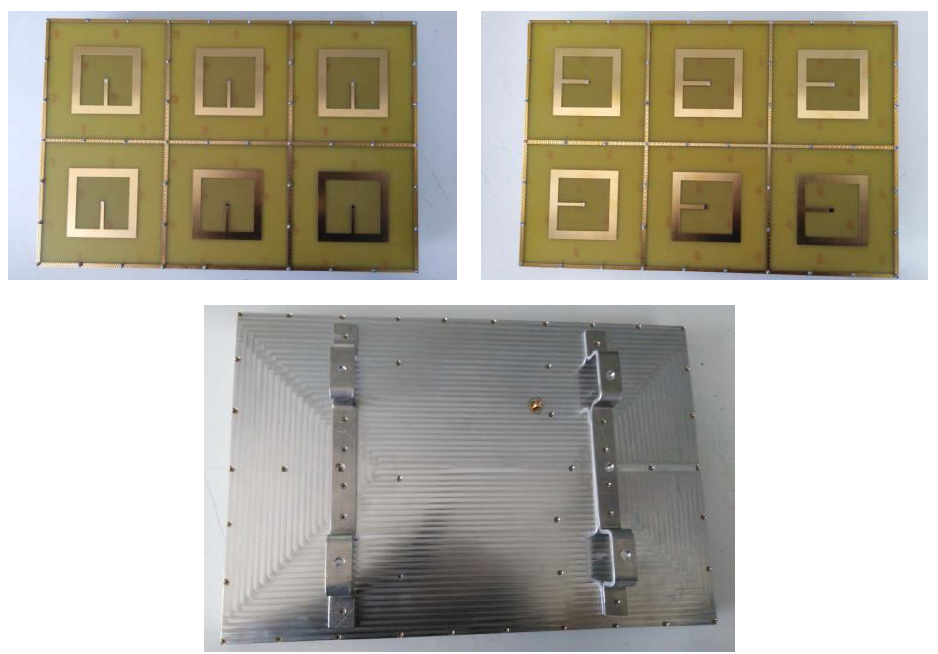
Fig. 1. L-band antenna design: vertical polarization antenna, aperture view (top left), horizontal polarization antenna, aperture view (top right), back side with fastening elements